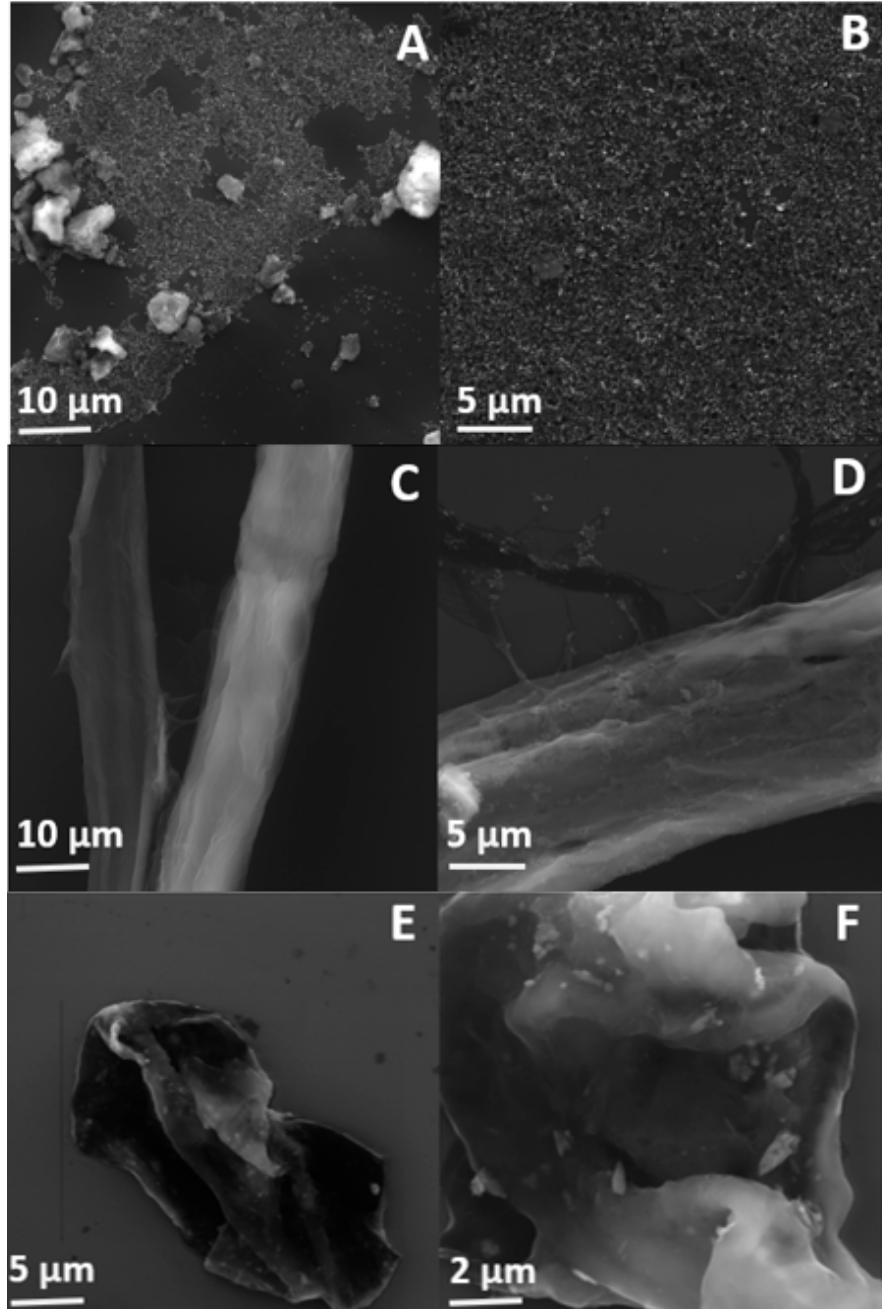
Figure 4. SEM micrographs of h-BN-OH nanosheets ( A , B ), cellulose fibers before ( C ) and after ( D ) the functionalization with h-BN-OH nanosheets, and cellulose fibers functionalized with h-BN-OH nanosheets after the ball-milling process ( E , F ).